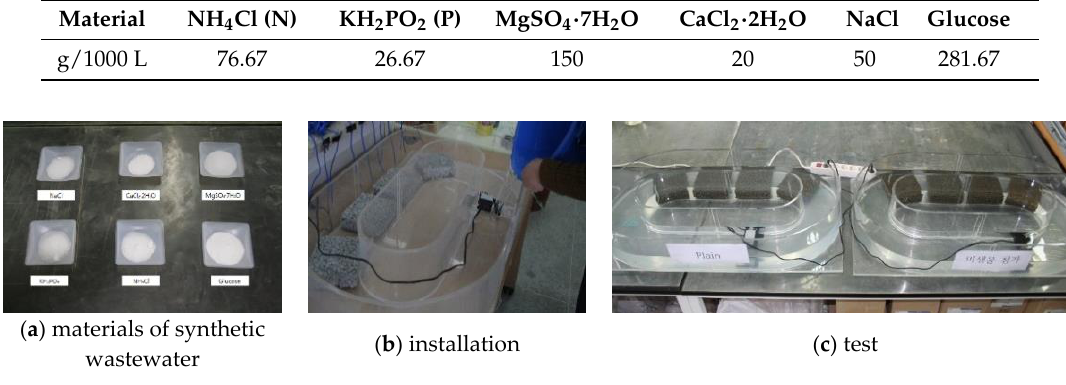
Figure 5. Water purification test